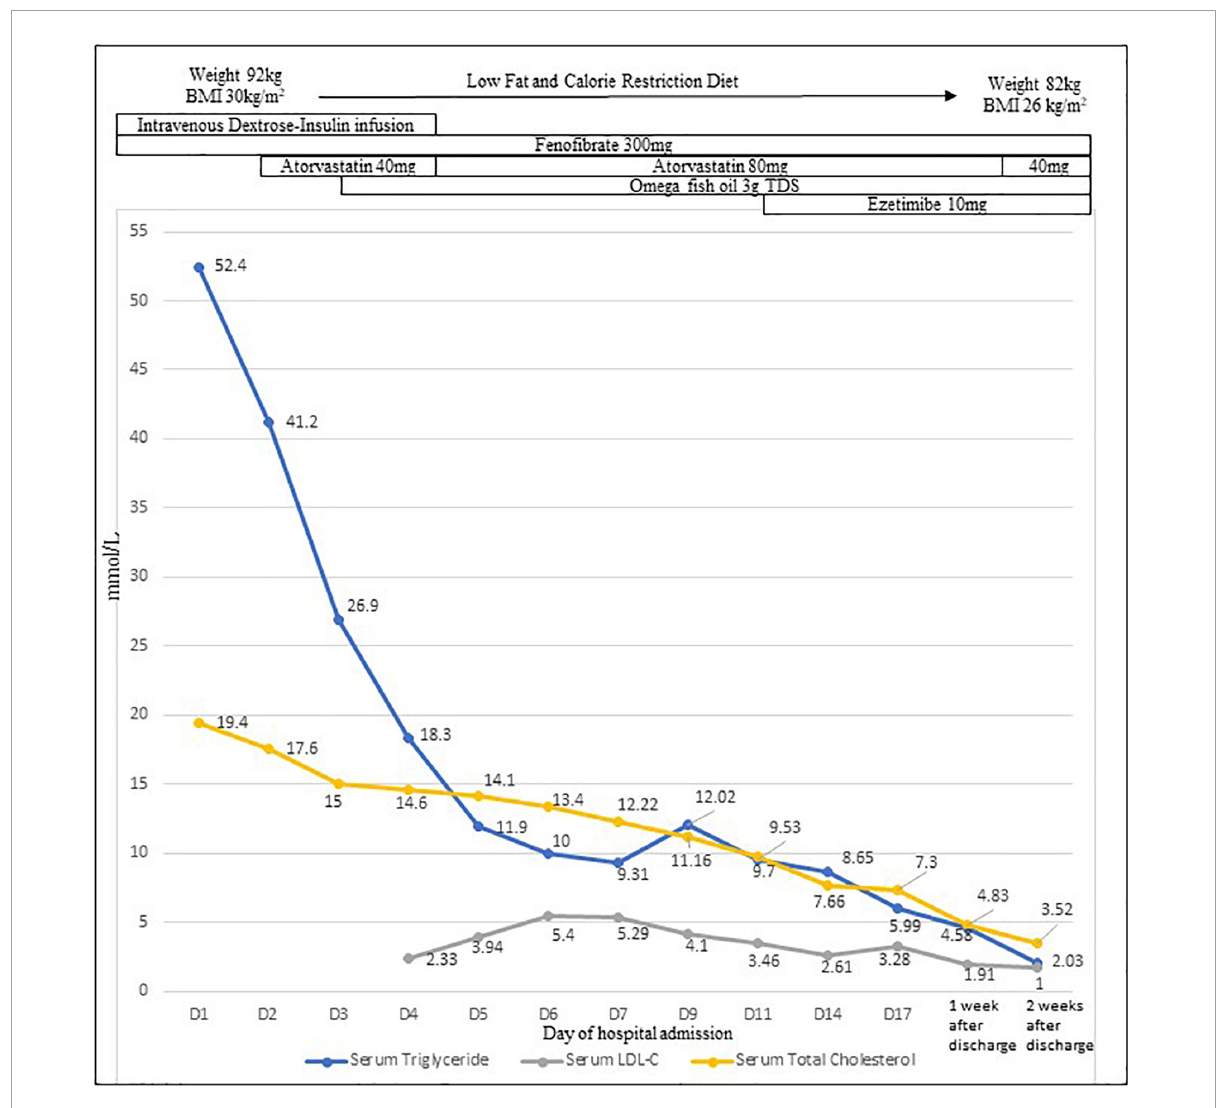
FIGURE2 Profiles of serum triglyceride level, CSF triglyceride level, serum total cholesterol, and LDL-C levels with